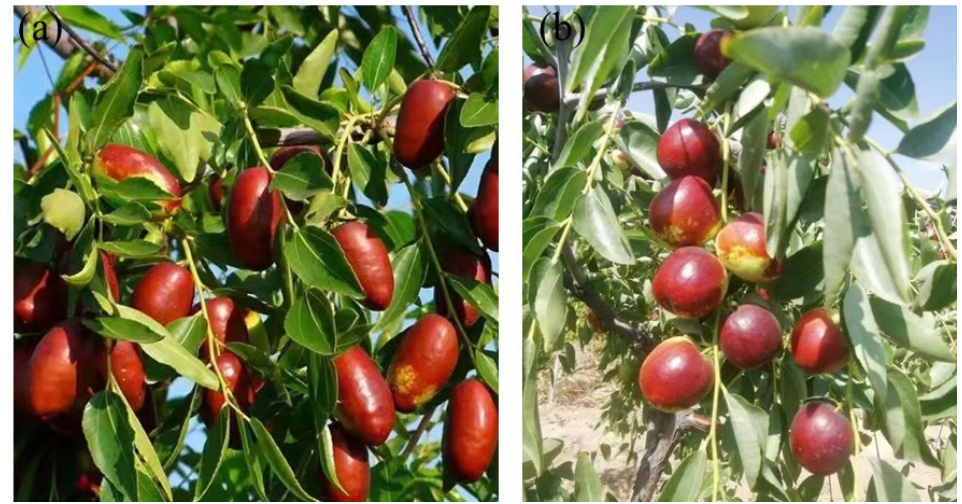
Figure 1. Jujube fruits of “Lingwu Changzao” ( a ) and “Tongxin Yuanzao” ( b ), the two traditional cultivars with Geographical Indications (GI) from Ningxia, China.